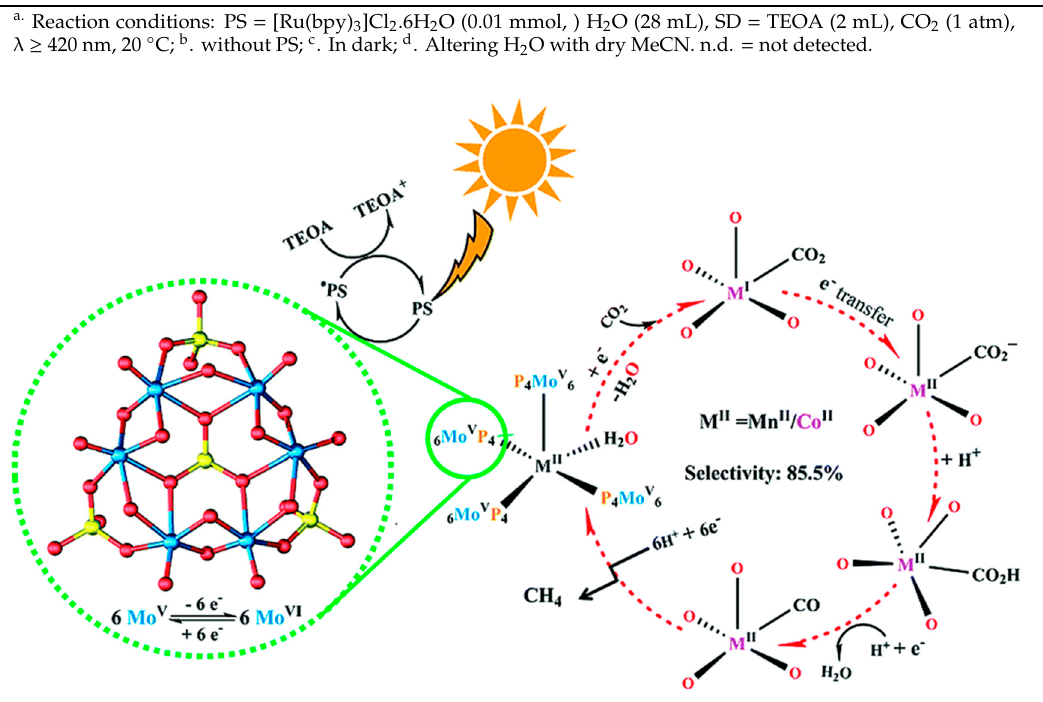
Figure 10. The proposed mechanism for photocatalytic reduction of CO 2 to CH 4 using NENU-605 or NENU-606. Color code: P, yellow ball; Mo, blue ball; O, red ball. Reprinted with permission from [50]. © 2019 Attribution-Non Commercial 3.0 Unported Licence (CC BY-NC 3.0).